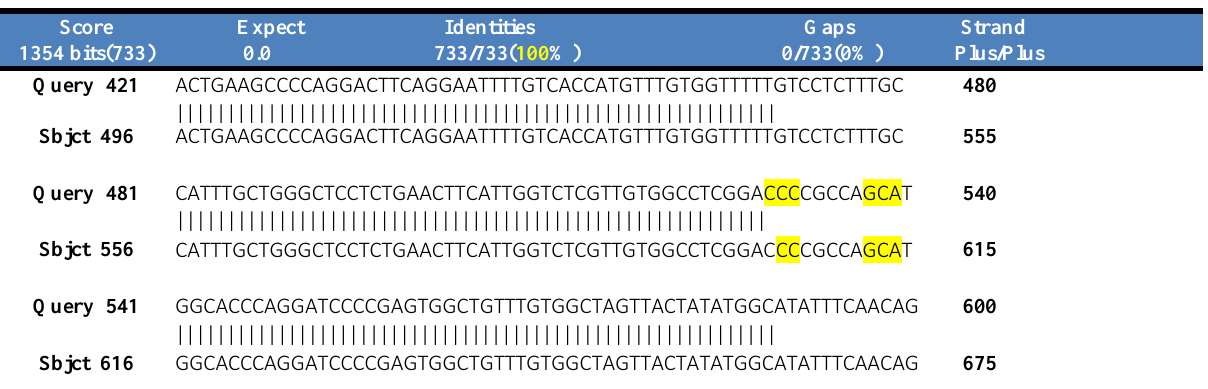
Figure, 1: Sequence ID: gb|HQ658147.1||Ovisaries isolate K45 melatonin receptor type 1A (MTNR1A) gene, MTNR1A-r allele, exon 2 and partial